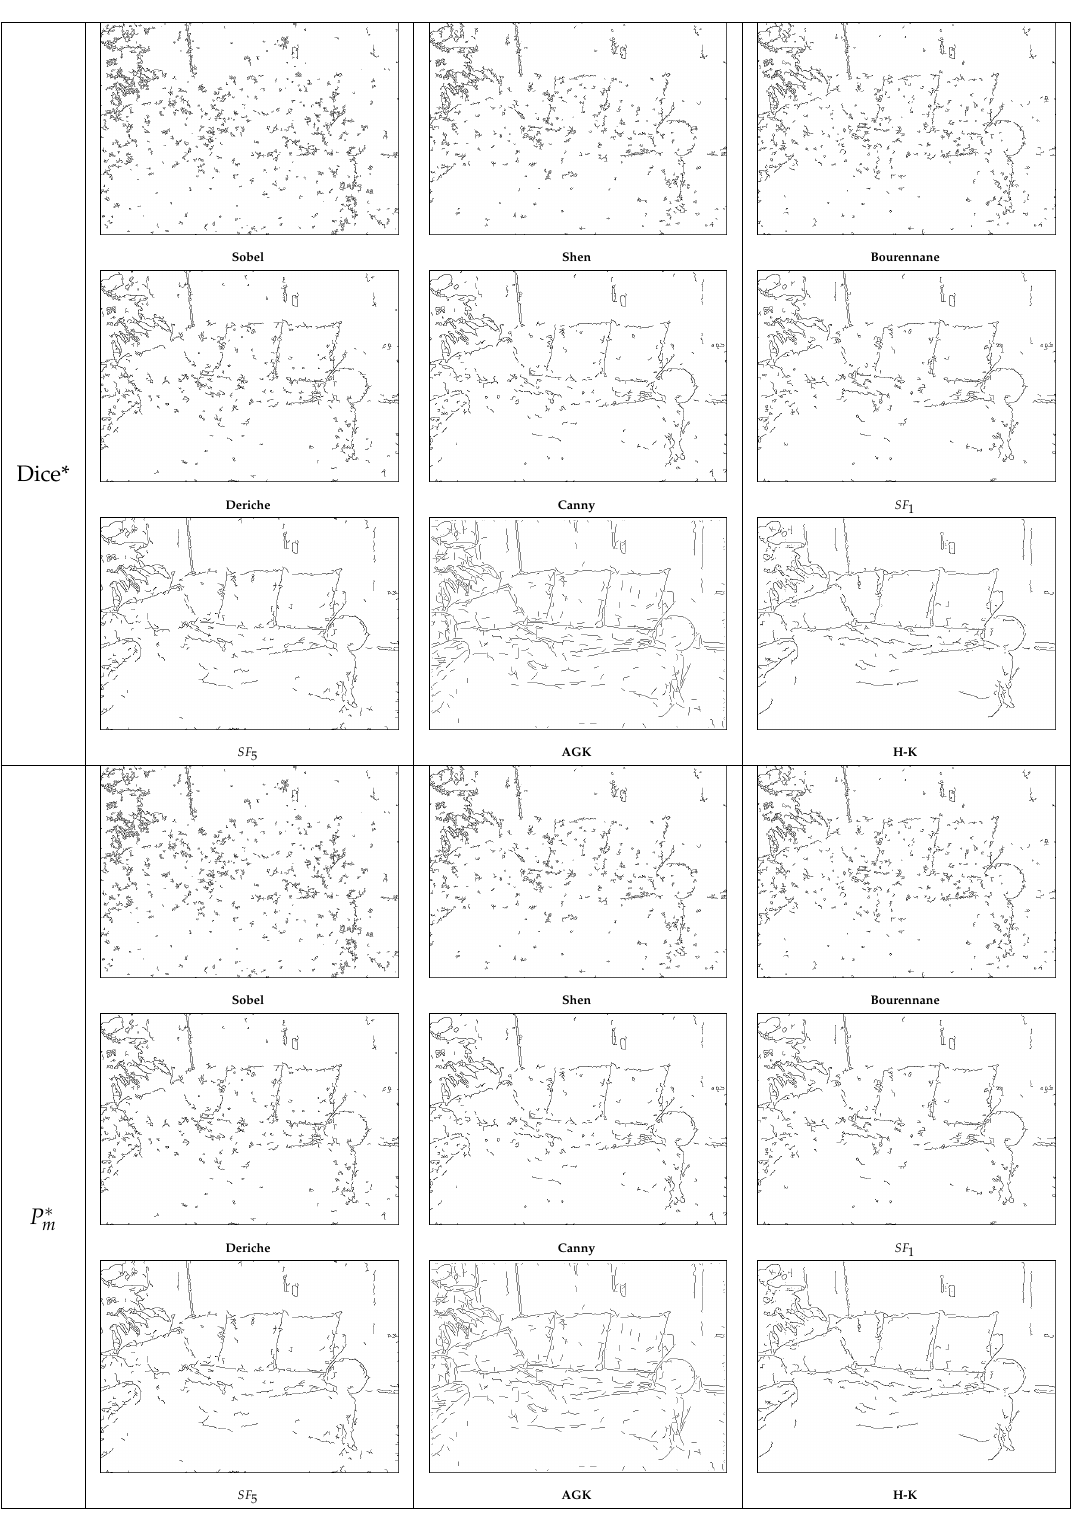
Figure 20. Ideal segmentations for several edge detectors on image 109, PSNR = 14